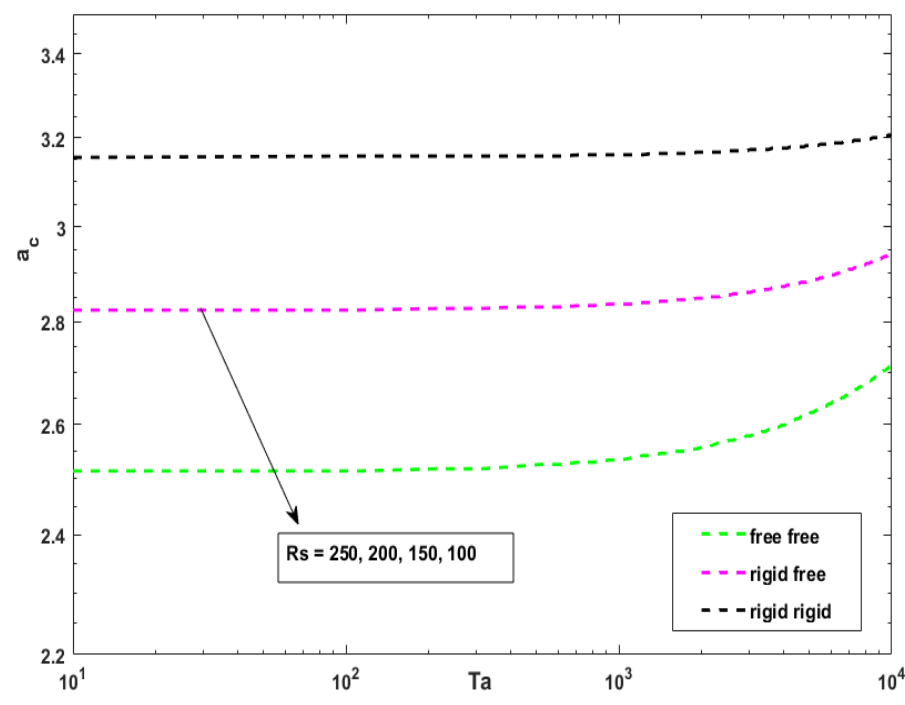
Figure 7. Variation of a c with Ta for Da = 0.01, Du = 0.02, Sr = 0.2, Le = 5, Λ = 8, M = 0.9, ϕ = 0.9.